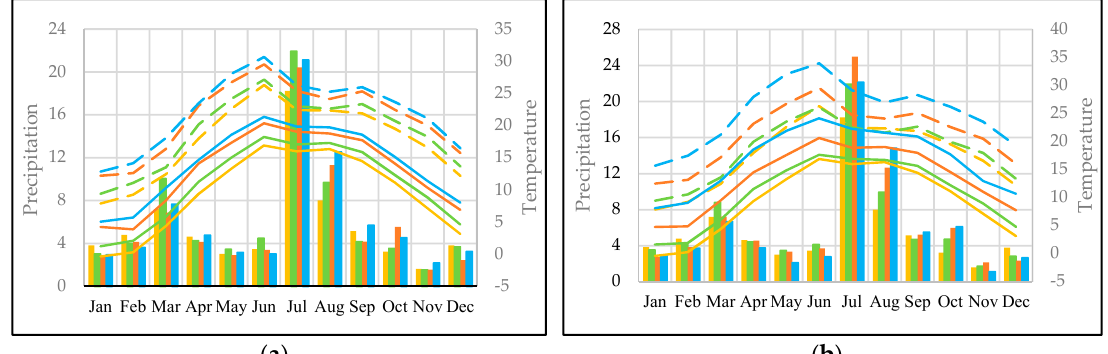
Figure 3. Mean monthly precipitation, maximum and minimum temperature for baseline and future period at P-1 under ( a ) RCP 4.5; ( b ) RCP 8.5. (Note: The bars represent the precipitation in mm/day, dashed lines represent maximum temperature in ◦ C and the solid lines represent the minimum temperature in ◦ C. Yellow color represents the baseline period, green color represents the early century, orange color represents the mid-century and the blue color represents the late century).